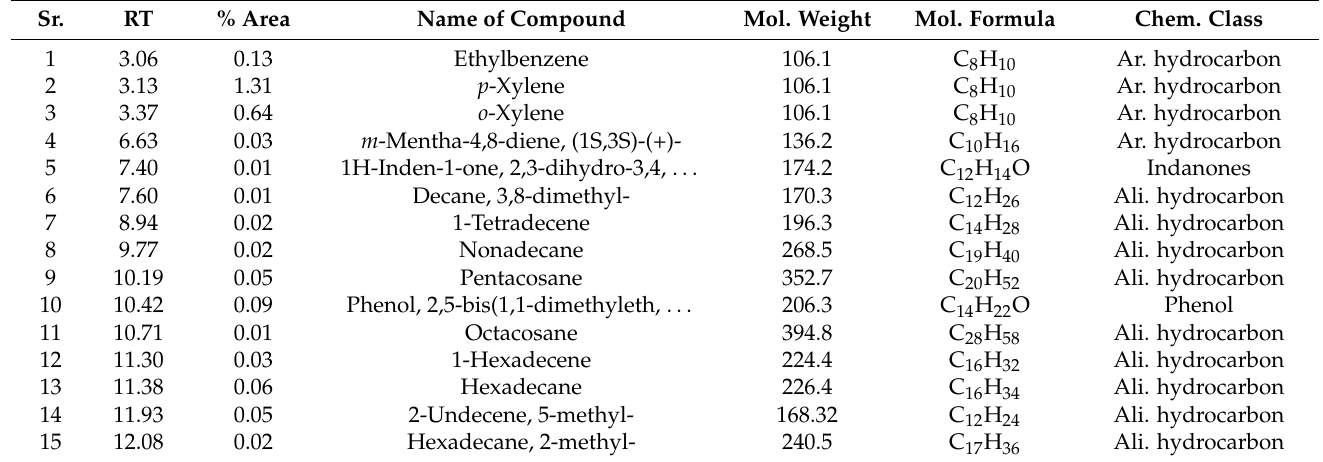
Table 2. GC-MS analysis of n -butanol fraction of S. glutinosus